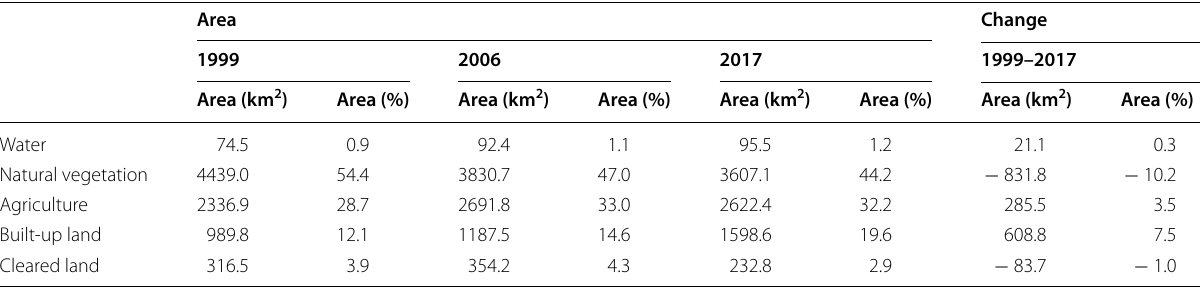
Table 1 Land cover area of each cover type for the years 1999, 2006, and 2017, and the changes for each cover type from 1999 to